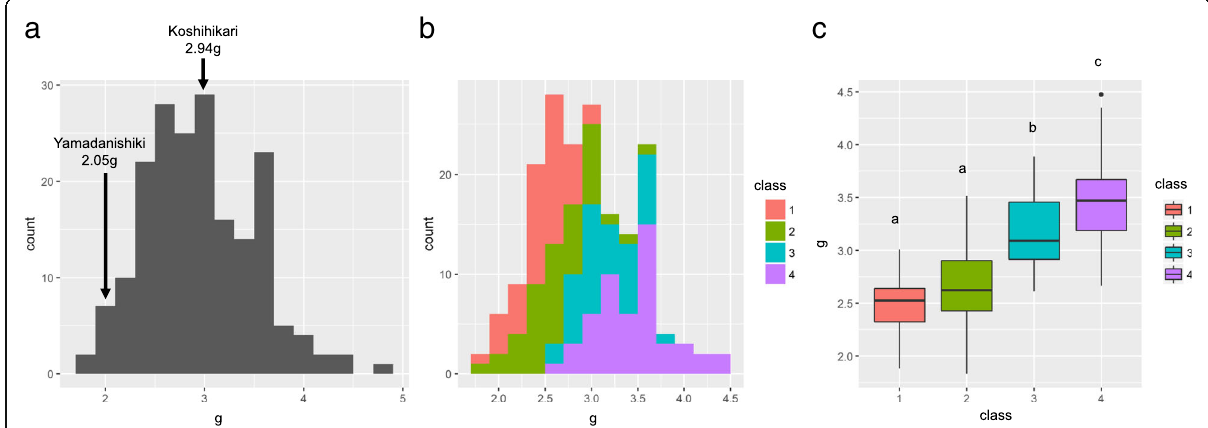
Fig. 1 Histograms ( a and b ) and boxplot ( c ) for one panicle weight (OPW) of the recombinant inbred lines (RILs) from Koshihikari and Yamadanishiki in 2014. The histogram ( a ) was drawn using all 190 RILs, and the histogram ( b ) and boxplot ( c ) used 180 RILs of homozygous genotypes at the nearest single nucleotide polymorphism markers of qOPW5 and qOPW11 . The 180 RILs were classified into four classes: class 1: qOPW5 _K and qOPW11 _Y (45 lines), class 2: qOPW5 _Y and qOPW11 _Y (44 lines), class 3: qOPW5 _K and qOPW11 _K (40 lines) and class 4: qOPW5 _Y and qOPW11 _K (51